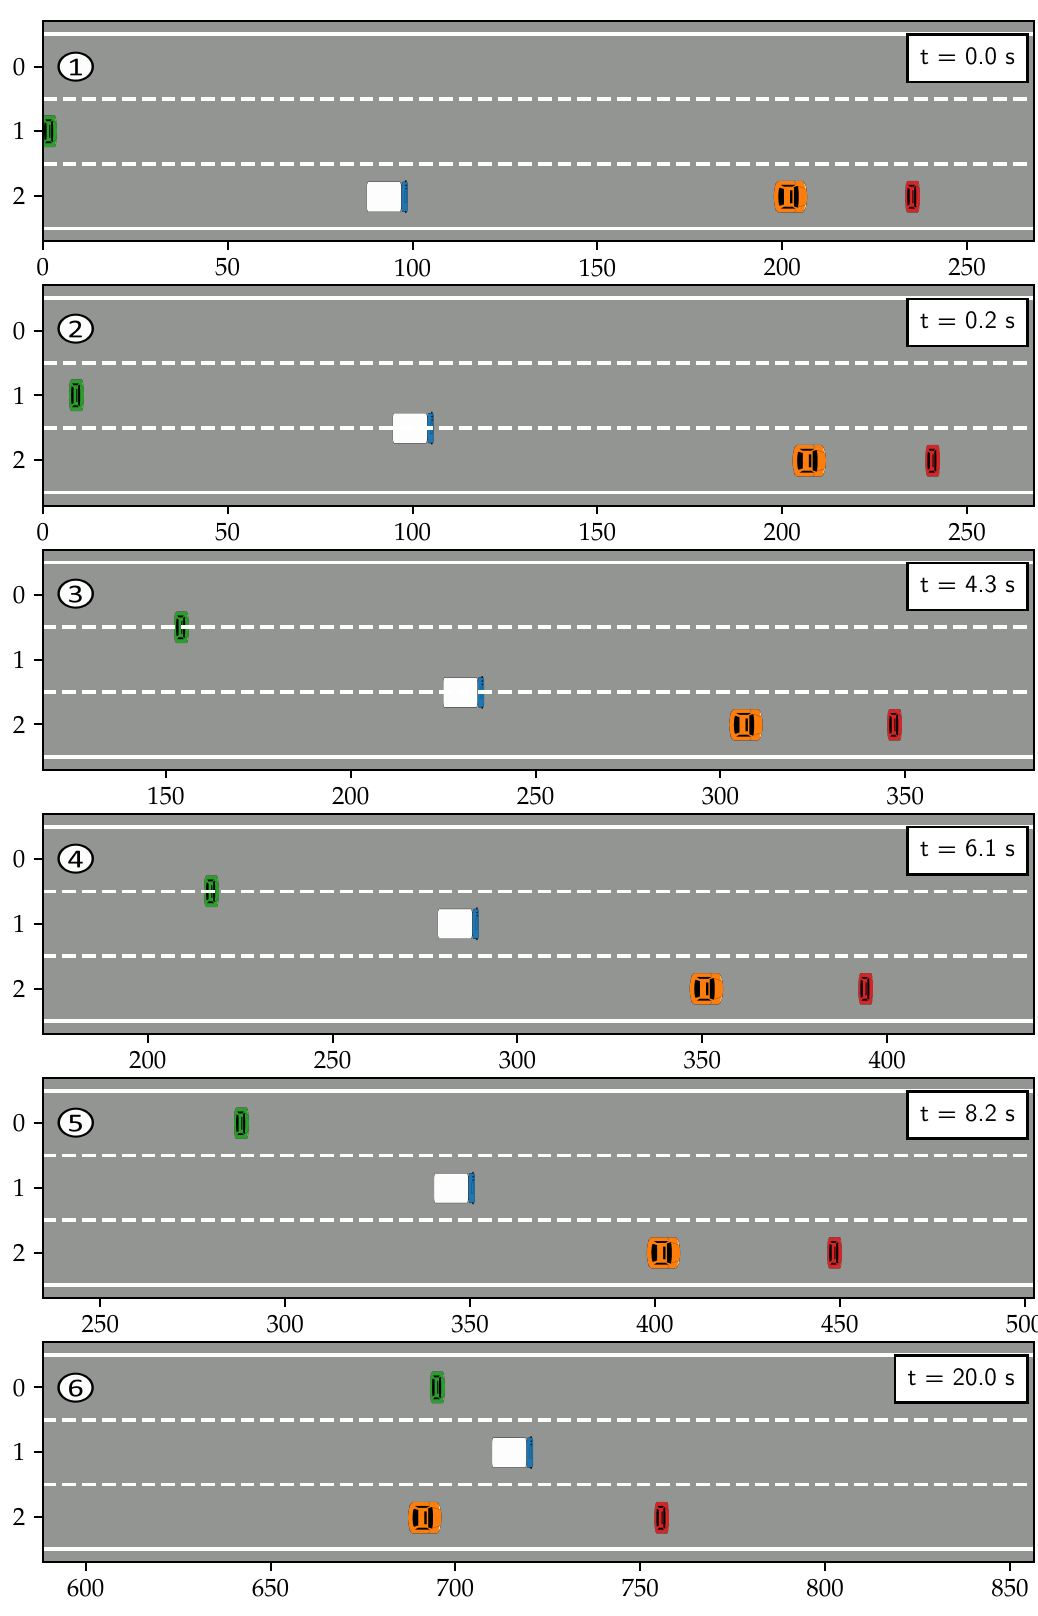
Figure 3. Lateral plot of the simple